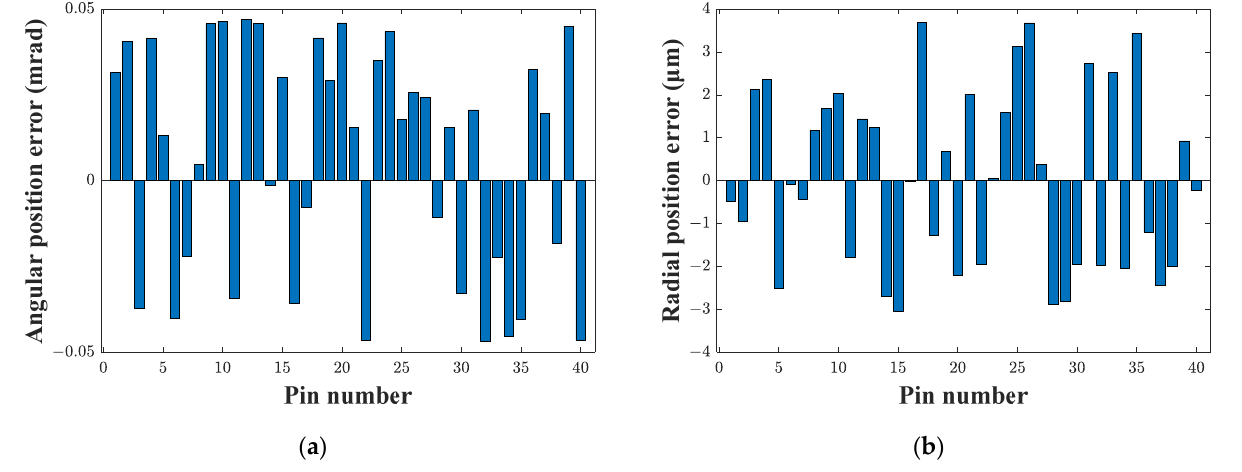
Figure 11. The random ( a ) angular and ( b ) radial position errors of all ring pins.